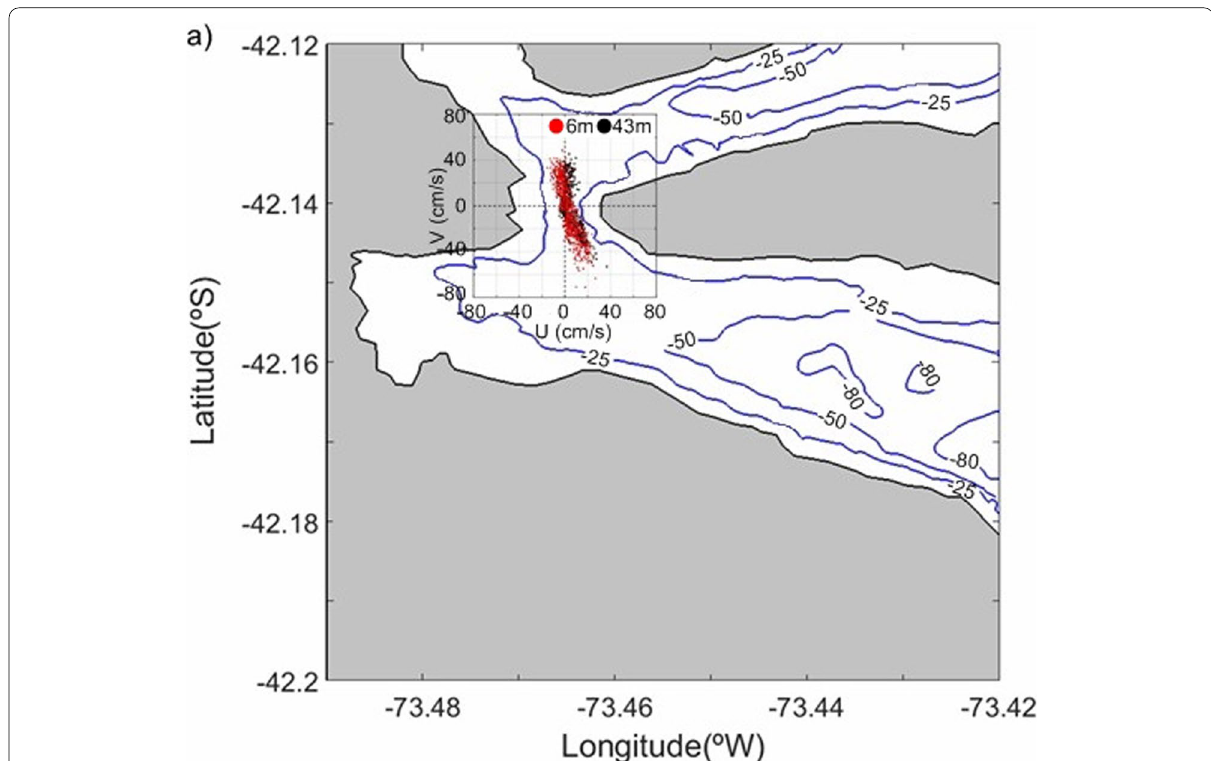
Fig. 8 Dispersion diagram of the total current at 6 m (red dots) and 43 m (black dots) depths measured in the Quemchi